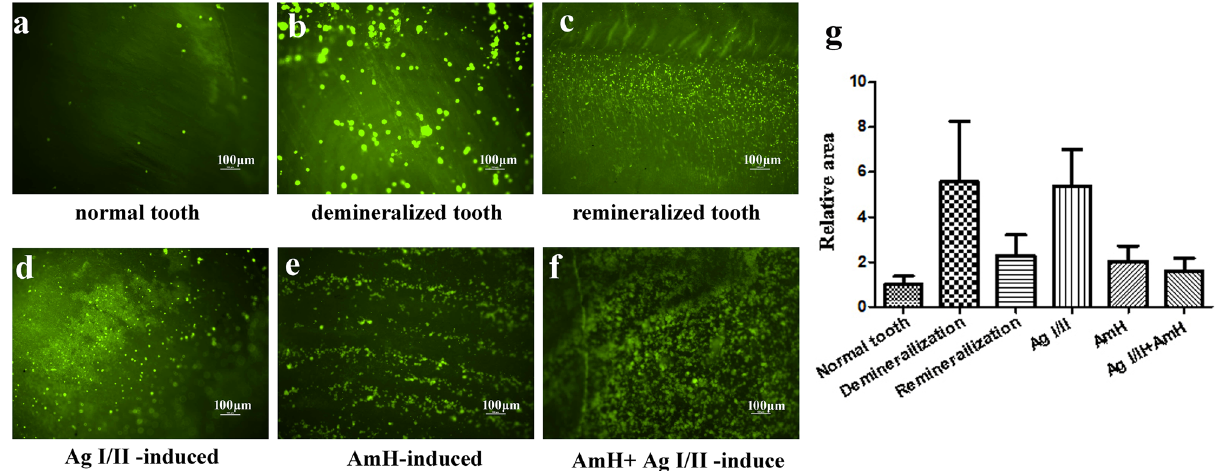
Figure 5. Fluorescence microscope images of S. mutans adhesion on the treated surface of the tooth. ( a ) normal tooth, ( b ) demineralized tooth, ( c ) remineralized tooth, ( d ) Ag I/II-induced crystals, ( e ) AmH-induced crystals, ( f ) AmH + Ag I/II-induced crystals. The right chart is the value of relative fluorescence intensity in each group. The demineralized group has the coarsest surface, and AmH group ranked second in this regard. The value for relative fluorescence intensity in the AmH + Ag I/II group was close to that if the remineralization group and higher than that of the AmH group. A Student’s t-test showed that the differences between the normal tooth vs demineralization (P = 0.0414), normal tooth vs Ag I/II (P = 0.0053) Ag I/II vs remineralization (P = 0.0064) were statistically